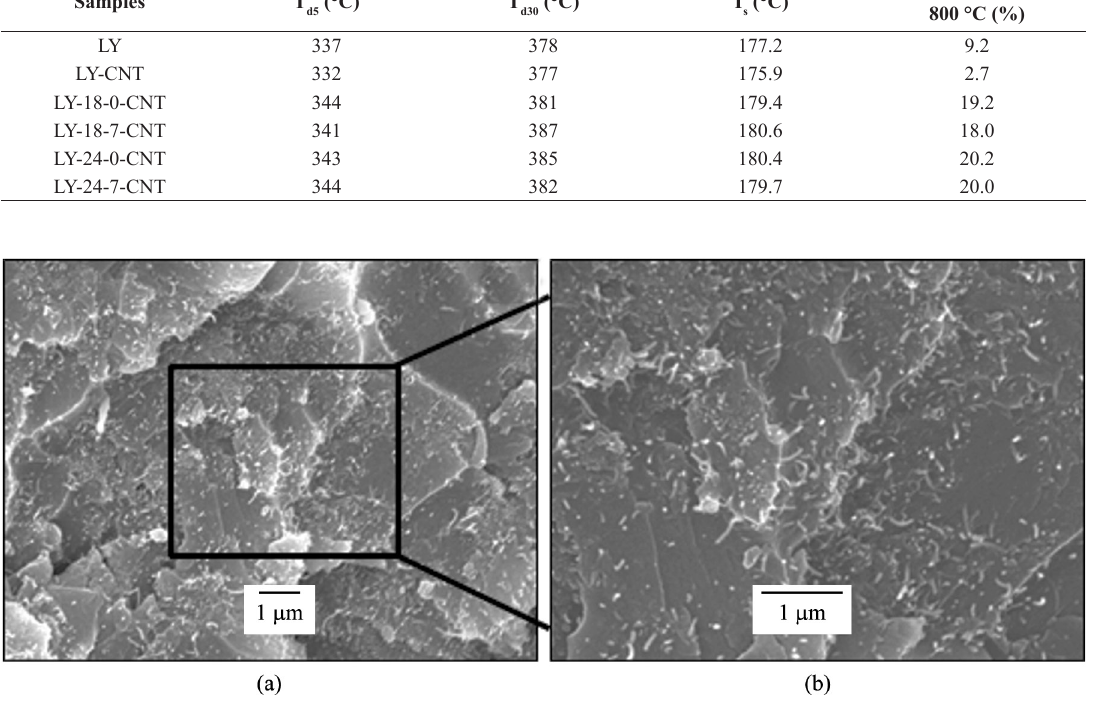
Figure 4. Regions of high concentration of MWCNT in the LY-18-0-CNT hybrid matrix.